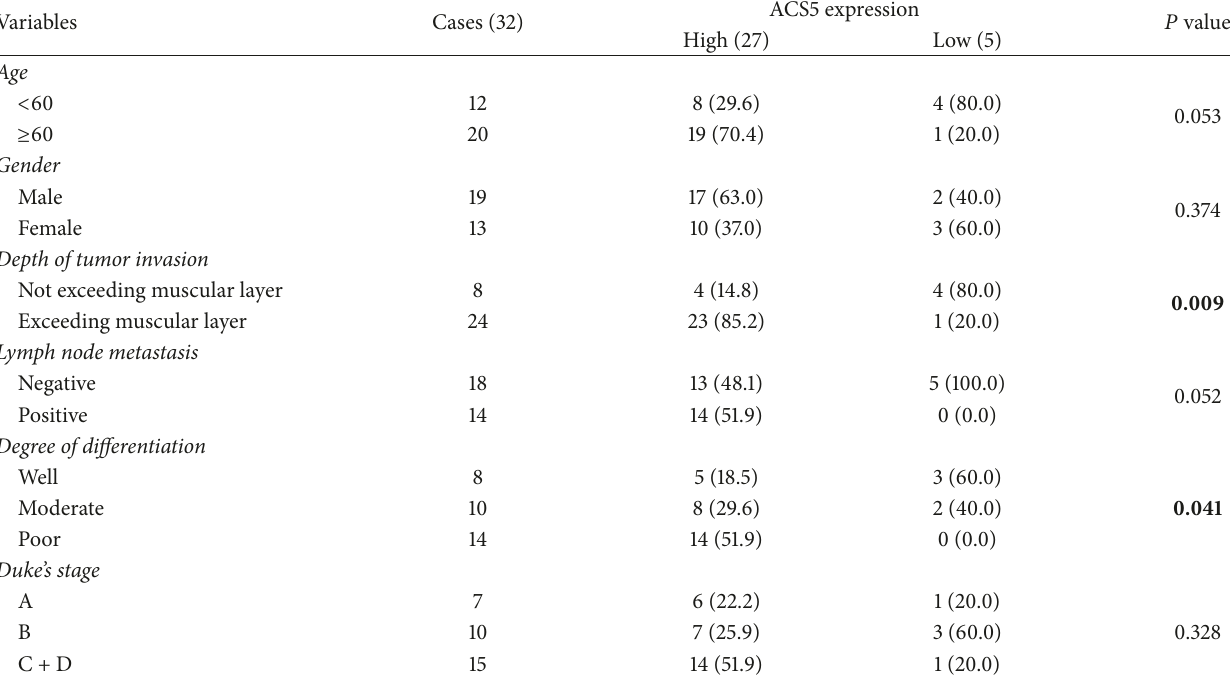
Table 1: Relationship between ACS5 expression and clinical pathological features of CRC 𝑛